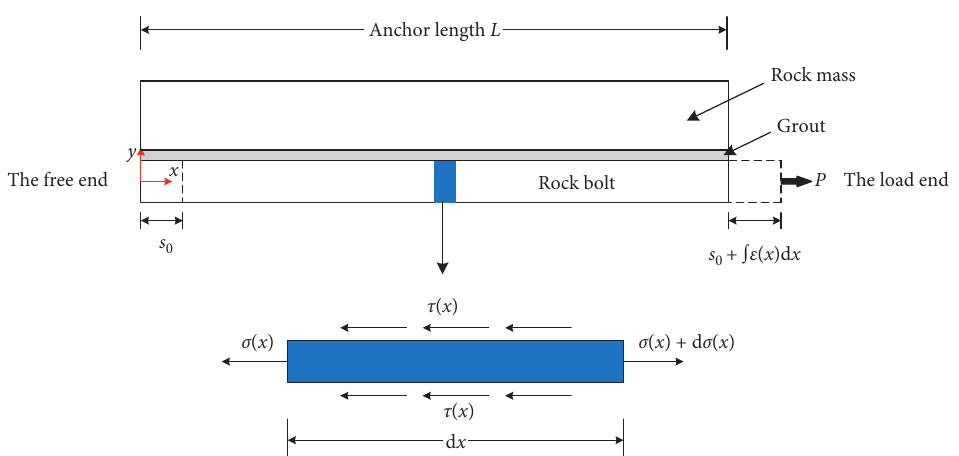
Figure 4: Calculation model of fully grouted bolt under tensile loading